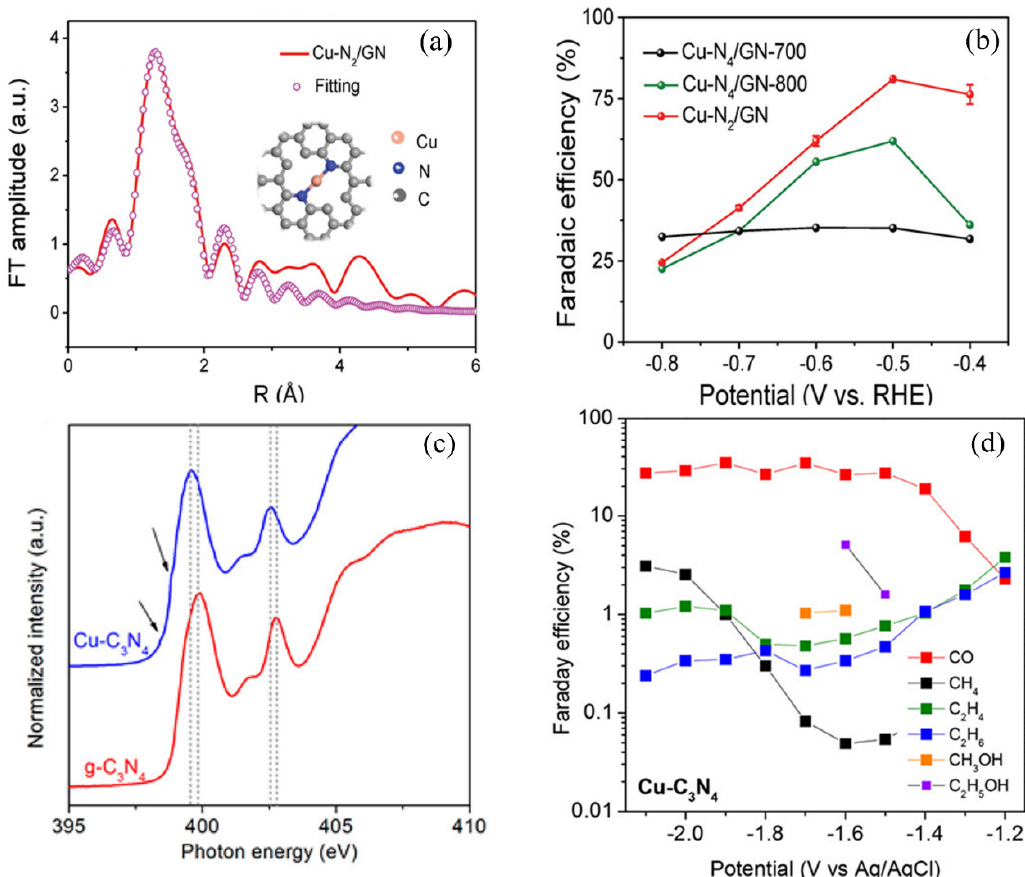
Figure 12. ( a ) Fourier transformed (FT)-EXAFS fitting results of Cu–N 2 /GN. ( b ) CO FE of Cu–N 4 /GN–700, Cu–N 4 /GN–800 and Cu–N 2 /GN. Reprinted from [108], Copyright 2020, with permission from Wiley. ( c ) Nitrogen K-edge NEXAFS of Cu–C 3 N 4 and pure g–C 3 N 4 . Arrows show the weak shoulders in the N K-edge assigned to the Cu–N interaction. Dotted lines show the channels of photon